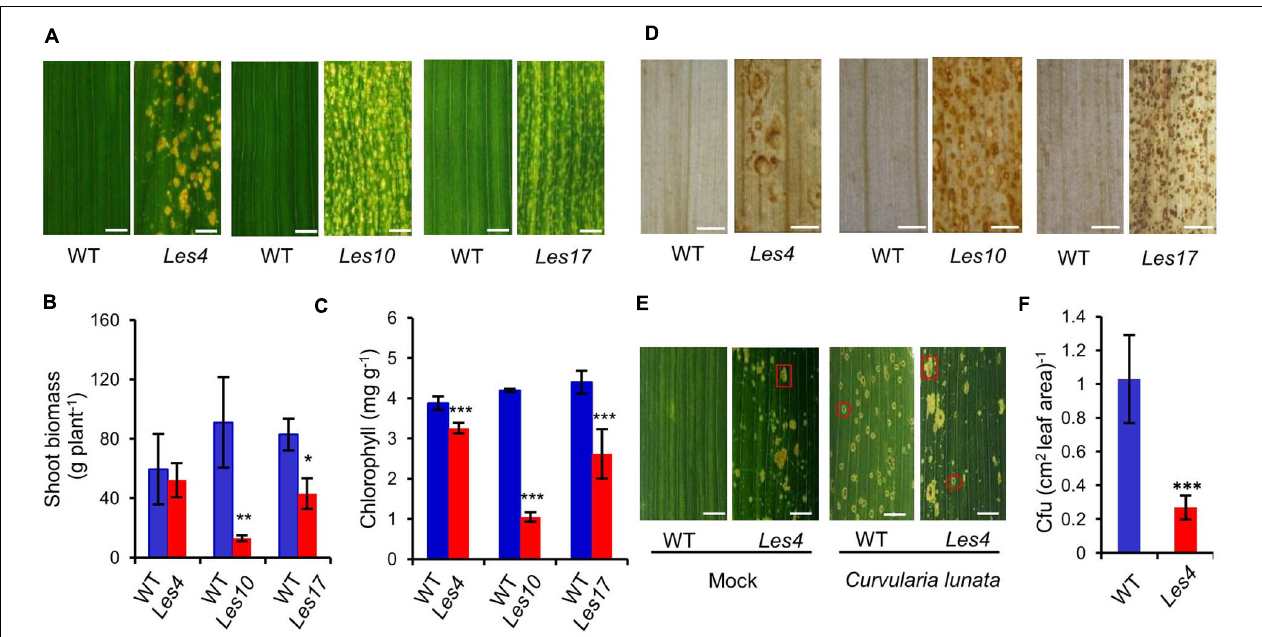
FIGURE 1 | Phenotypic and physiological characterization of the Les4 , Les10 , and Les17 . (A) Morphologies of Les4 , Les10 , and Les17 mutants and their respective wild type (WT). Scale bars = 5 mm. (B) The shoot biomass and content of chlorophyll in Les4 , Les10 , and Les17 mutants and their respective WT. (C) The total chlorophyll content in Les4 , Les10 , and Les17 mutants and their respective WT. (D) Images of DAB-stained leaves of in Les4 , Les10 , and Les17 mutants and their respective WT. Scale bars = 2 mm. (E) Morphologies of Mock and Curvularia lunata -infected WT and Les4 plant leaves 7 days after inoculation. A typical spontaneous lesion was indicated by a red square, and a typical curvularia -leaf spot-disease lesion was indicated by a red circle. Scale bars = 7.5 mm. (F) Quantification of Curvularia lunata colonies in Mock and Curvularia lunata -infected WT and Les4 plant leaves 7 days after inoculation. For (B,C,F) , asterisks indicate significant differences compared with WT samples (Student’s t -test; * P < 0.05; ** P < 0.01; *** P < 0.001). Error bars represent standard